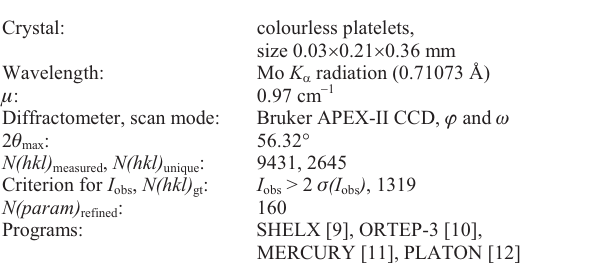
Table 2. Atomic coordinates and displacement parameters (in Å 2 )